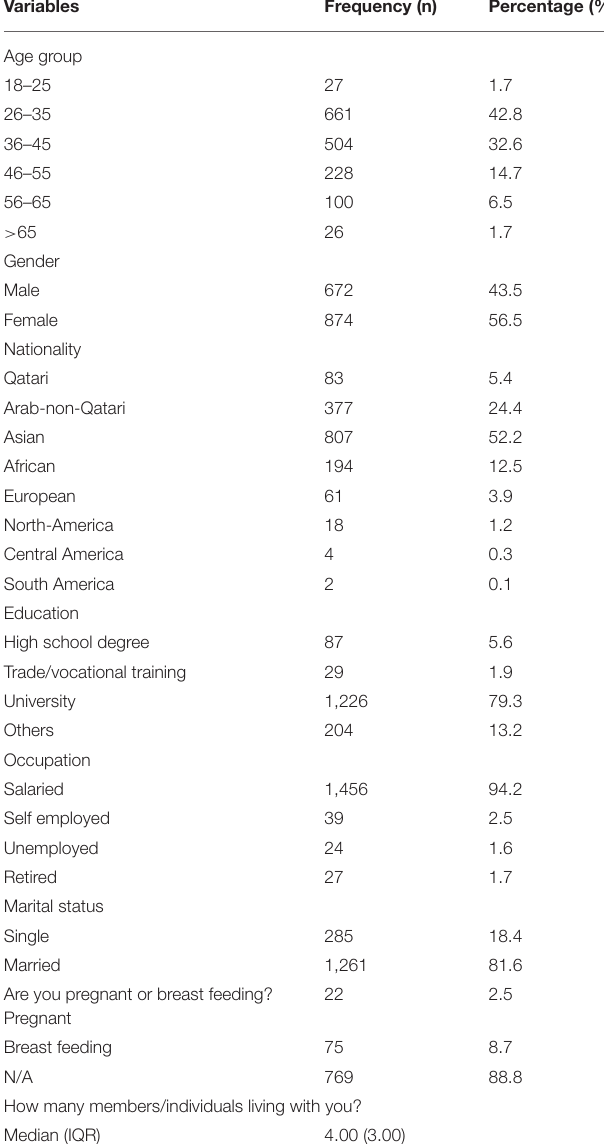
TABLE 1 | Demographic data and characteristics of participants ( n =